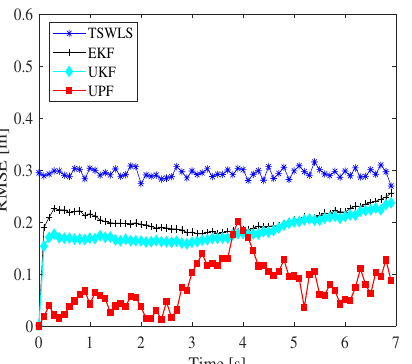
Figure 19. The RMSE of different algorithms in LOS scenario ( σ θ